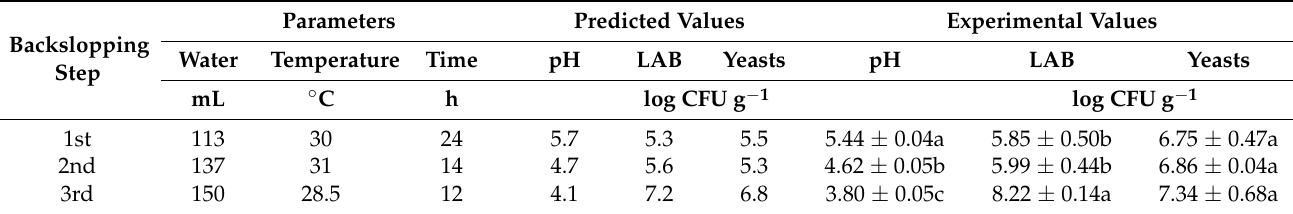
Table 6. Optimized factors in the three backslopping steps of fermentation and experimentally determined characteristic parameters: pH, LAB and yeasts